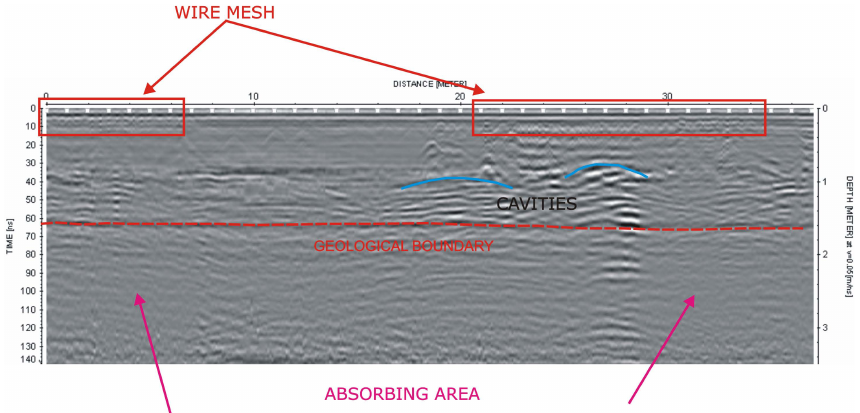
Fig. 3. SN1 georadar profile carried out along San Nicola